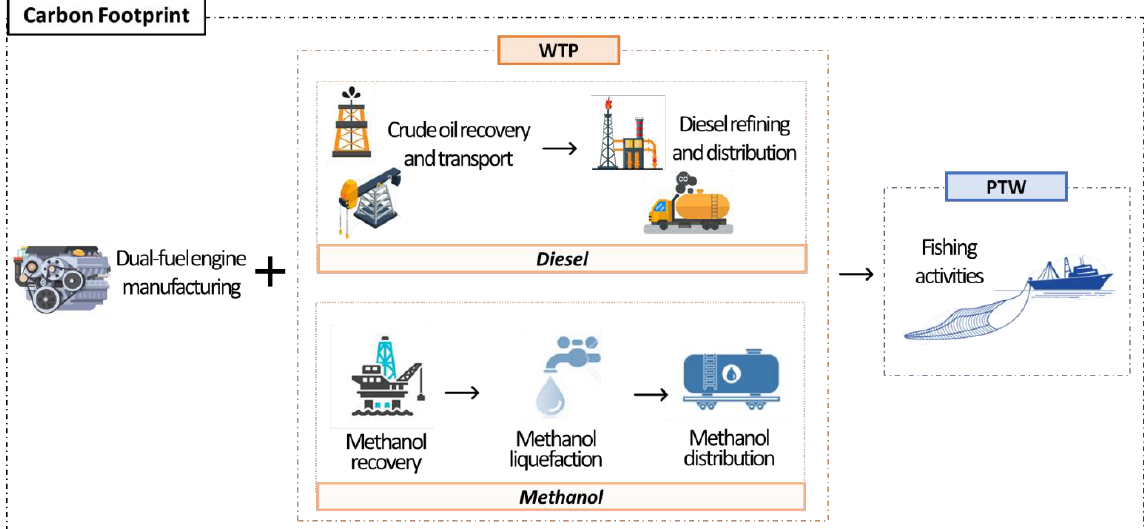
Figure 7. The LCA of a methanol-powered trawler.